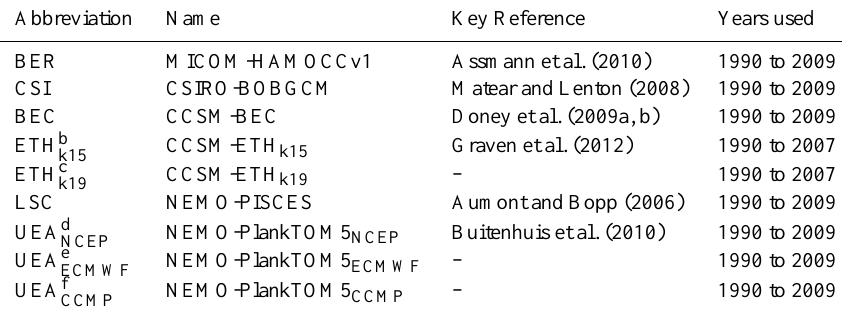
Table 2. Ocean general circulation models with biogeochemistry (OBGCMs) a .